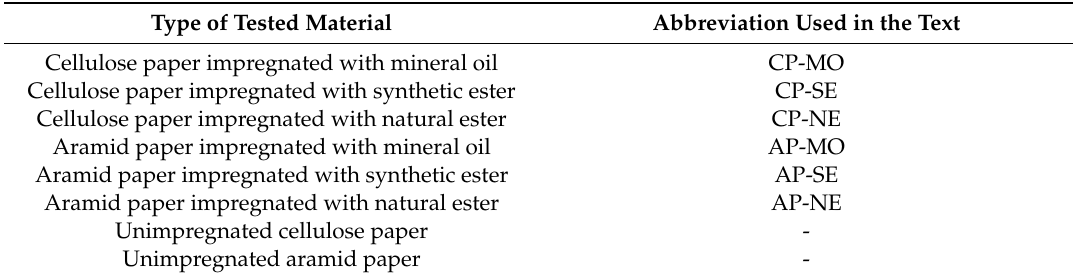
Table 1. Combinations of papers impregnated with insulating